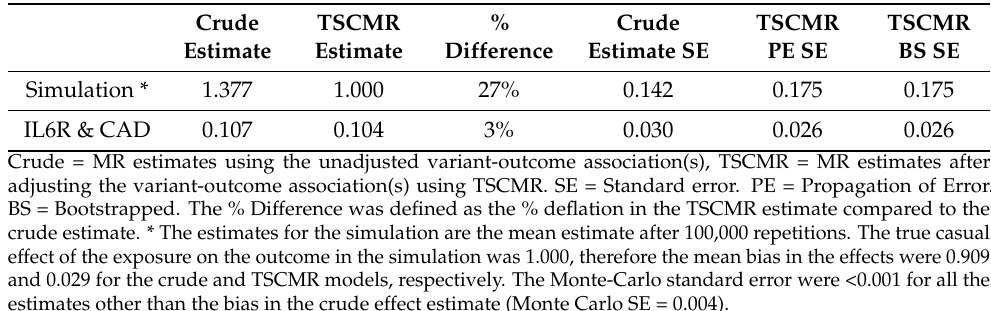
Table 1. Results of simulation and applied example.